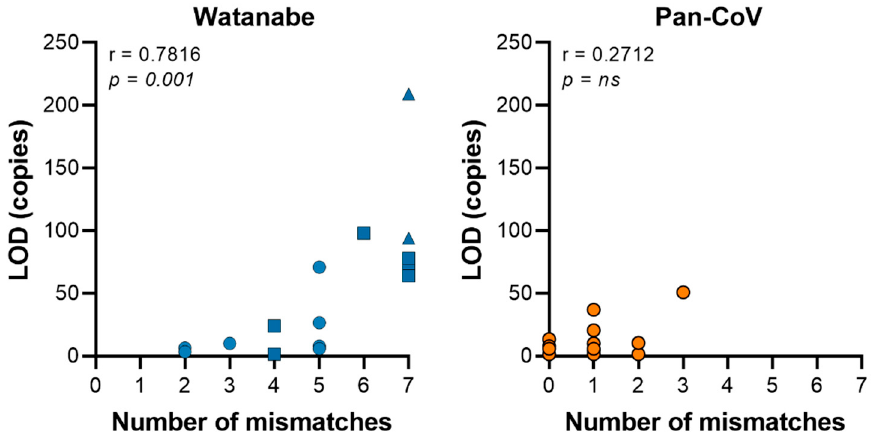
Figure 2. Limit of detection (LOD) for the Watanabe and Pan-CoV PCR assays . The LOD was determined for both assays for 15 CoVs from four genera. # = the total number of primer mismatches. * = not detected in assay.